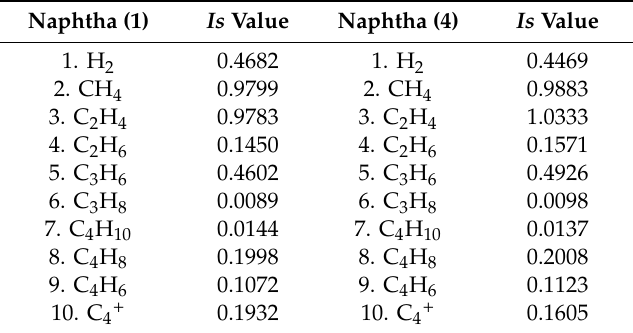
Table 13. The initial